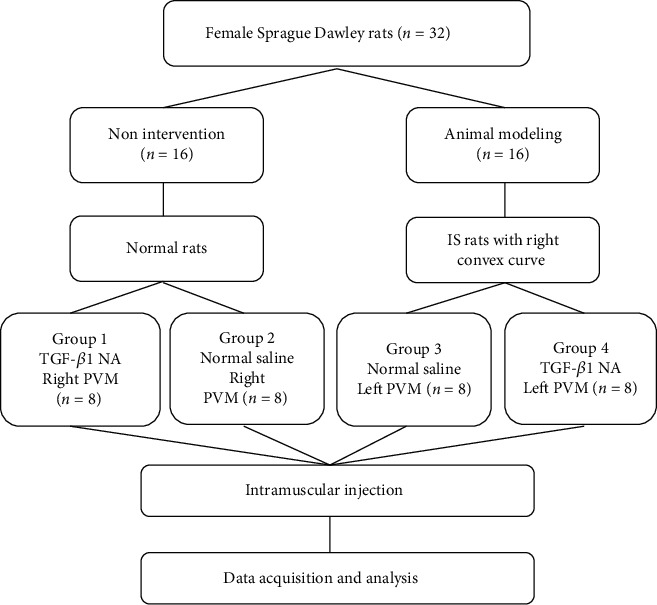
The study design.